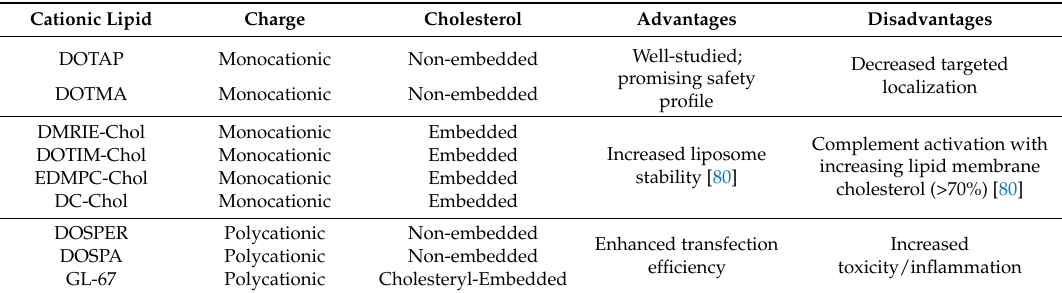
Table 1. Examples of cationic lipids used in clinical trials